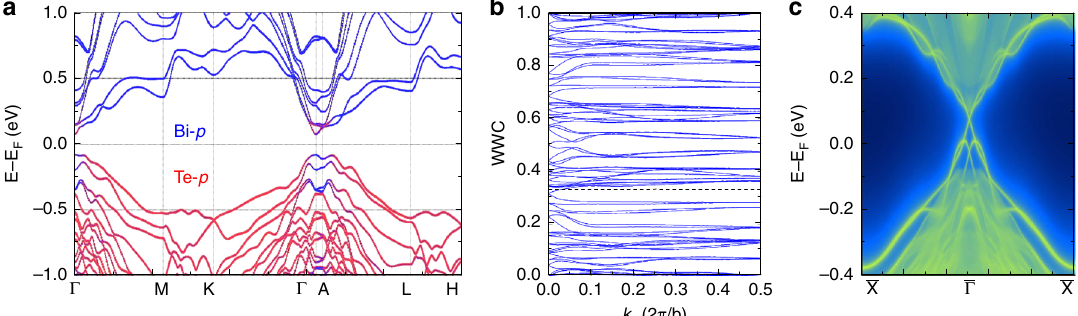
Fig. 3 Topological properties of bulk AFM MnBi 4 Te 7 predicted by fi rst-principles calculations. a Band structure with the projection of Bloch eigenstates onto Bi- p (blue) and Te- p (red) orbitals. SOC is included. b Evolution of Wannier charge centers (WCCs) for k z = 0, indicating a nontrivial topological invariant Z 2 = 1. c Surface spectra of (010) side surface, showing a gapless Dirac cone protected by S